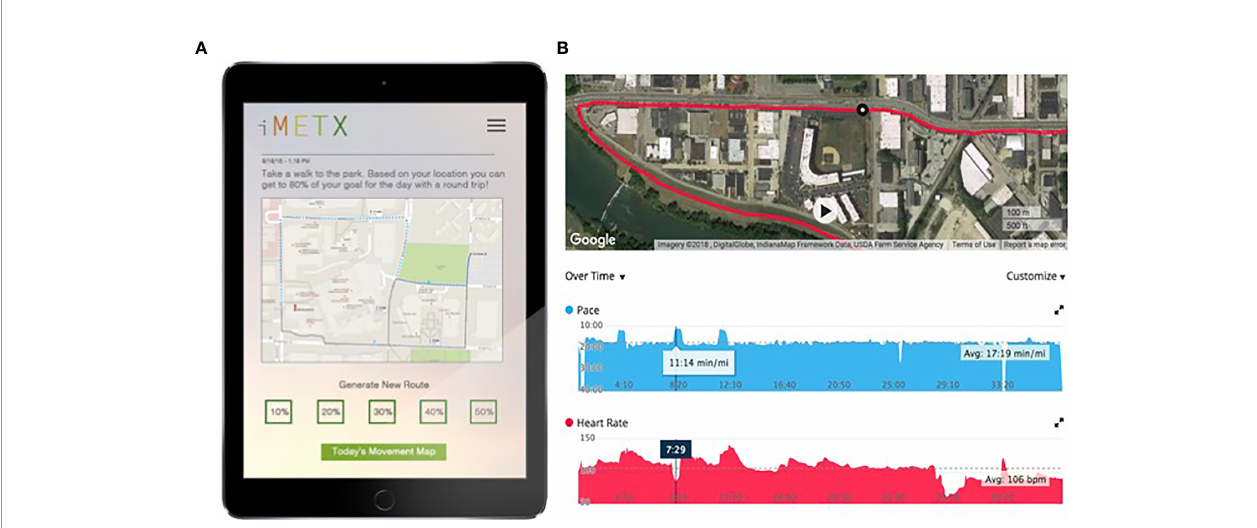
FIGURE 1 | Example of patient interface and energy expenditure data. (A) displays patient view of movement prescription to incorporate bursts of more vigorous activity into her walks. (B) displays the same patient ’ s movement within her community, incorporating the prescription as evidenced by changes in her pace and heart